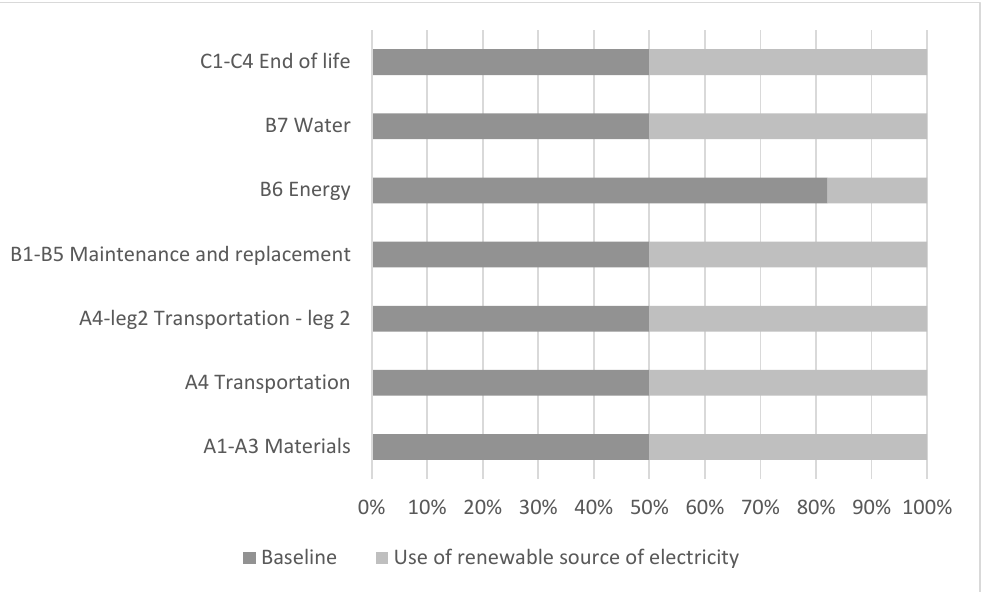
Figure 9. Comparison between baseline and use of the renewable source of electricity.